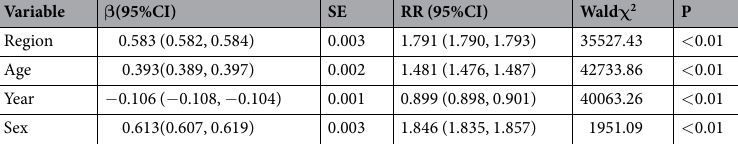
Table 1. Comparison of the U5MR between in minority and non-minority